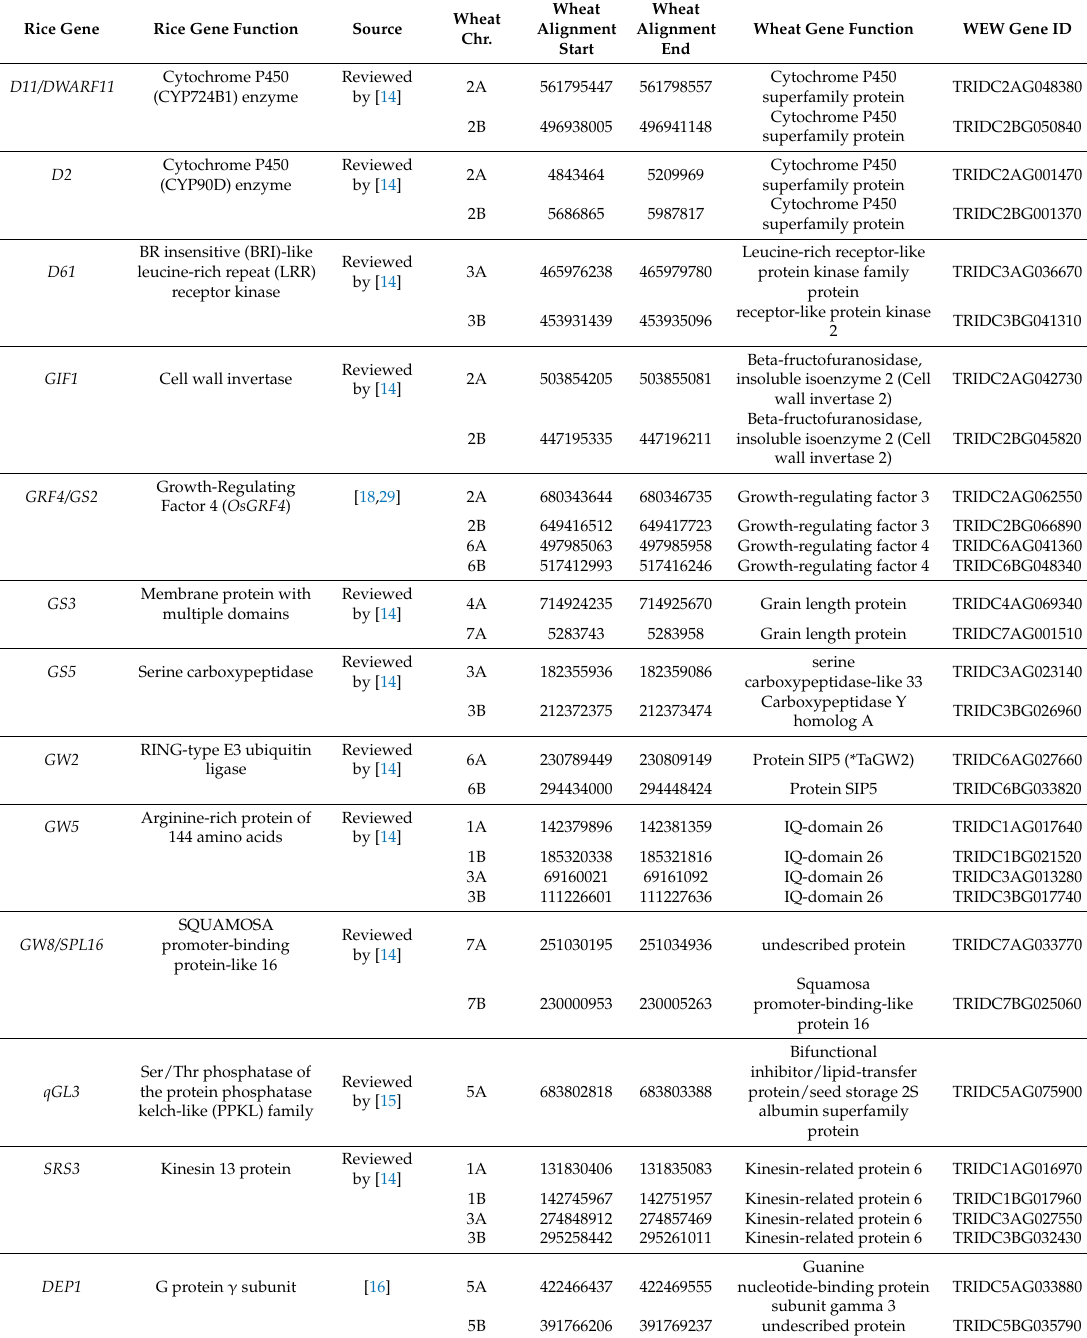
Table 2. Summary of yield-related genes in rice and their WEW